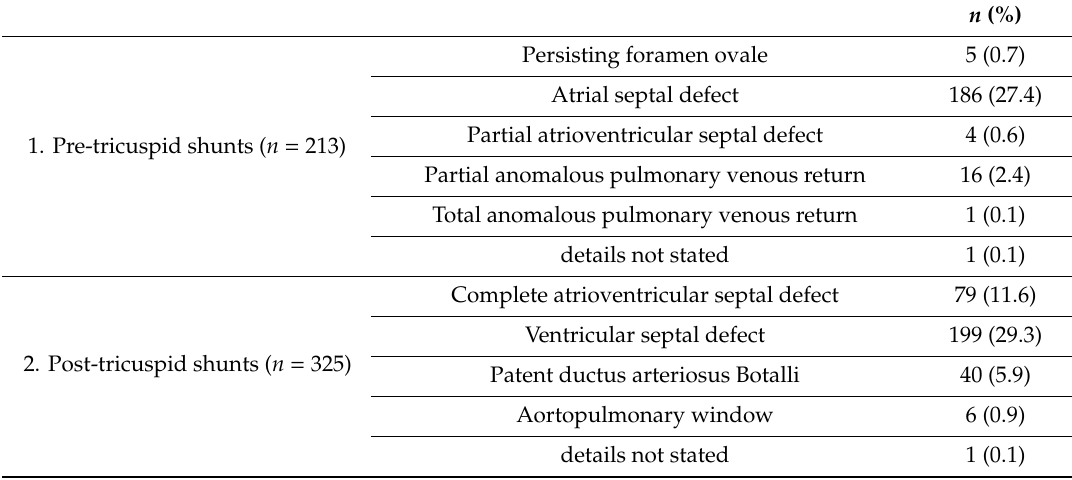
Table 4. Subgroups of adult patients with PAH, and types of congenital heart defects.